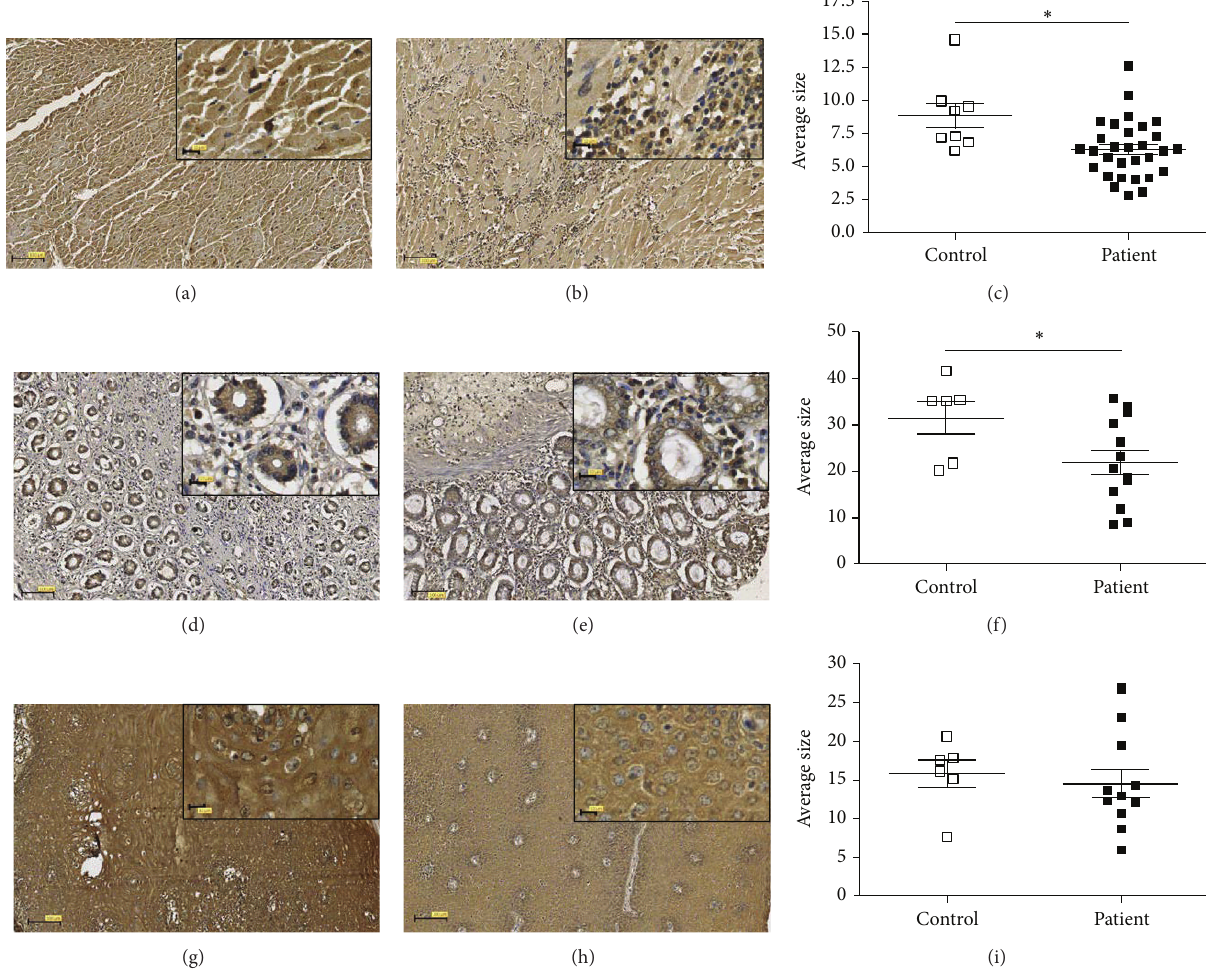
Figure 1: Immunohistochemical staining for HLA-G. Representative photomicrographs ((a), (b), (d), (e), (g), and (h)) and average size ((c), (f), and (i)) of HLA-G-stained cells in heart ((a)–(c)), colon ((d)–(f)), and esophagus ((g)–(i)) of controls ((a), (d), and (g)) and patients ((b), (e), and (h)). The insert boxes show a higher magnification of the HLA-G-stained cells in each tissue. Scale bar 100 𝜇 m, 12 𝜇 m (insert). ((c), (f), and (i)) Data are expressed as mean ± SEM. ∗ 𝑃 < 0.05 indicating statistical significance compared with